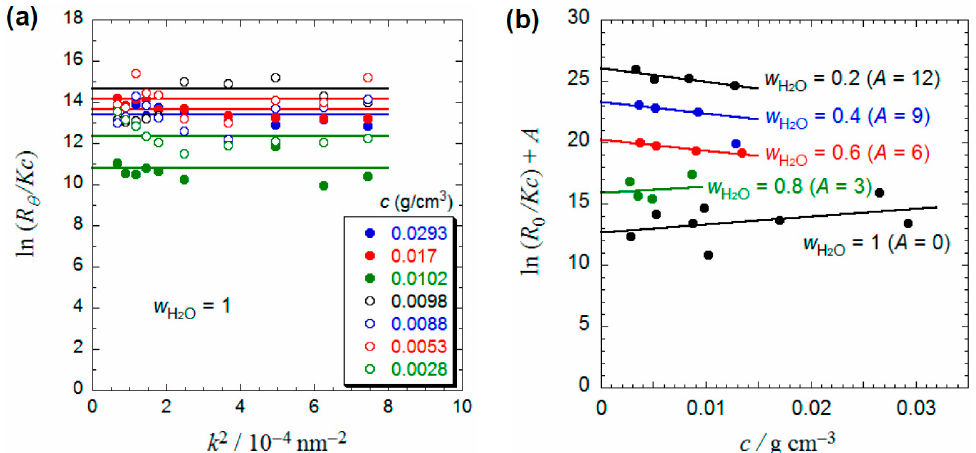
Figure 1. ( a ) Guinier plots of PFSI in water at different polymer concentrations c at 25 °C; and ( b ) plots of ln( R 0 /Kc ) vs. c of PFSI in water-MeOH mixtures with different w H 2 O at 25 °C.